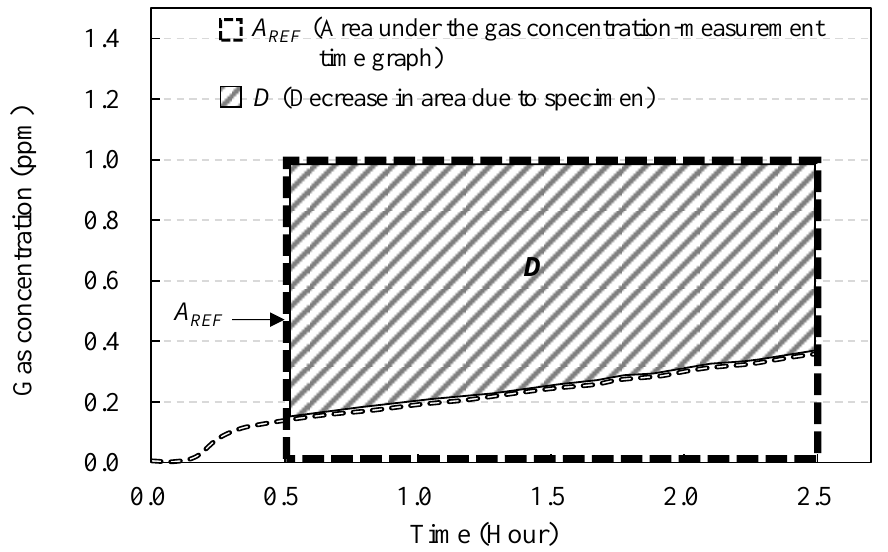
Figure 6. Variation of gas concentration with respect to time.